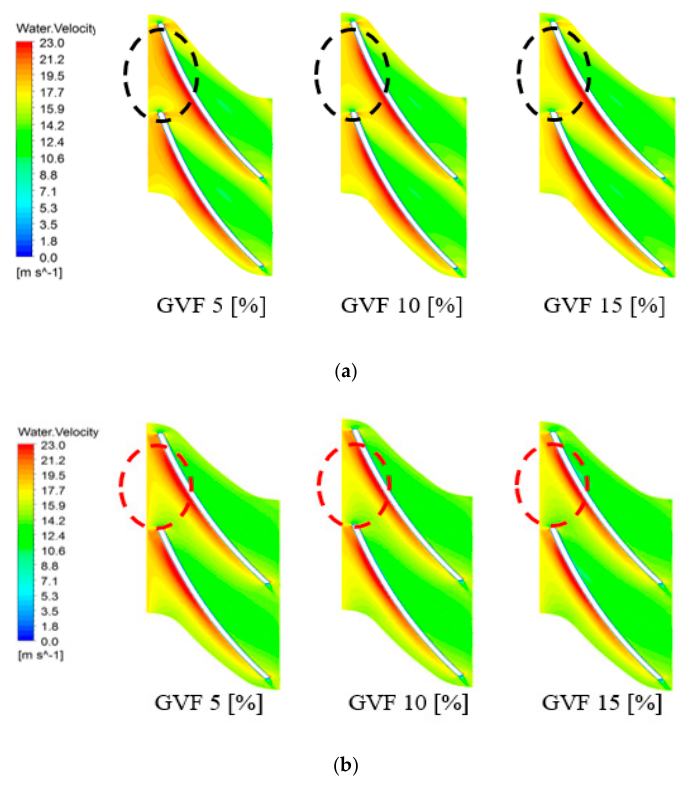
Figure 12. Velocity contour at mid-span along the GVF up to 15%. ( a ) 2nd base impeller at the blade to blade plane; ( b ) 2nd optimum impeller at the blade to blade plane.